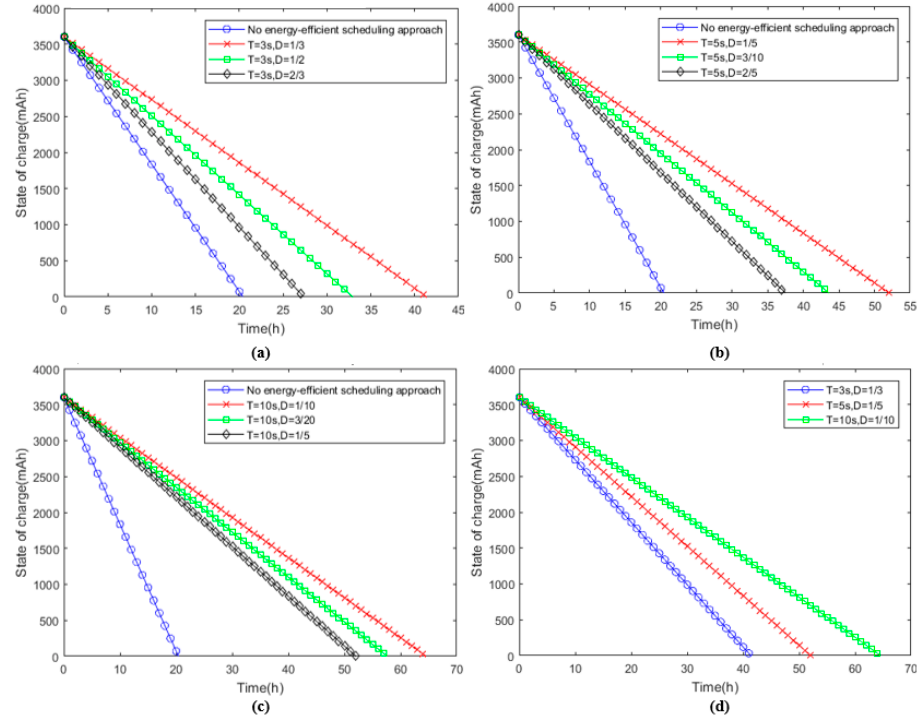
Figure 6. Comparison diagram of lifetime. ( a ) State of charge under different duty ratios when the period is 3 s. ( b ) State of charge under different duty ratios for 5 s. ( c ) State of charge under different duty ratios for 10 s. ( d ) State of charge with different cycles and the same wake-up time. In Figure 6, the horizontal axis represents time and the vertical axis represents the state of charge. The initial capacity is 3600 mAh. It can be seen from Figure 6a–c that the duty cycle is the main factor affecting the lifetime of the WSND. Duty cycle and lifetime vary inversely. Therefore, when the cycle time is constant, the duty cycle should be set to be as small as possible. As seen in Figure 6d, when the active time is the same, the lifetime of the WSND increases with an increasing duty cycle. 4. Validation We conducted tests on the experimental line of the national HVDC test base and actual UHVDC transmission lines to verify the effectiveness of the energy-efficient scheduling approach. As shown in Figure 7, the sensors and wireless nodes were arrayed linearly along the direction perpendicular to the transmission lines. According to the parameters of the transmission lines and test environment, 12 to 20 WSNDs were used in the experiments.